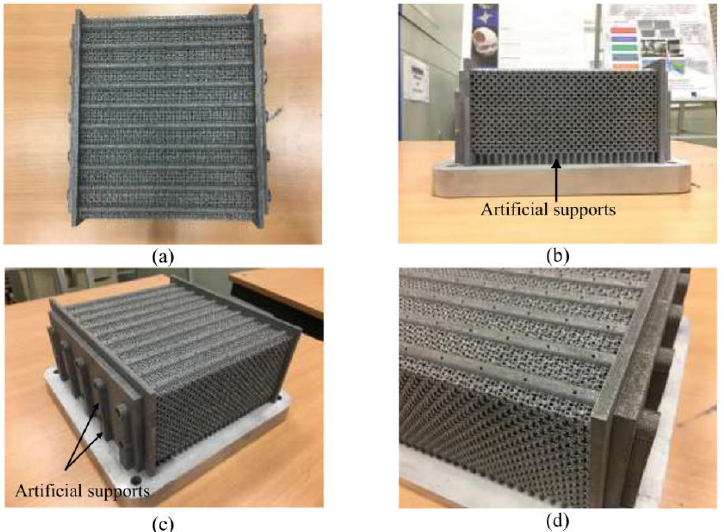
Figure 6. A porous/lattice heat exchanger design. ( a ) top view, ( b ) side view, ( c ) isometric view and ( d ) zoom-in view. Reprinted/adapted with permission from Ref. [80] . 2019, Elsevier Ltd. The porous/lattice structures used in heat exchangers usually have two types, i.e., an octet truss porous/lattice structure [81 – 83] or a microporous/lattice structure [84]. The octet truss porous/lattice structure, due to its superior structural characteristics produced by its increased connectivity, has been widely used in multifunctional heat exchangers and electric applications [81 – 83]. Chaudhari [81] experimentally investigated the effective thermal conductivity and wall Nusselt number in heat exchangers with octet truss lattice porous/lattice structures. The results indicated that the octet truss lattice porous/lattice structure is a good selection to bear compressive loads and dissipate heat. Heat and fluid flow characteristics of octet truss lattice porous/lattice structures with